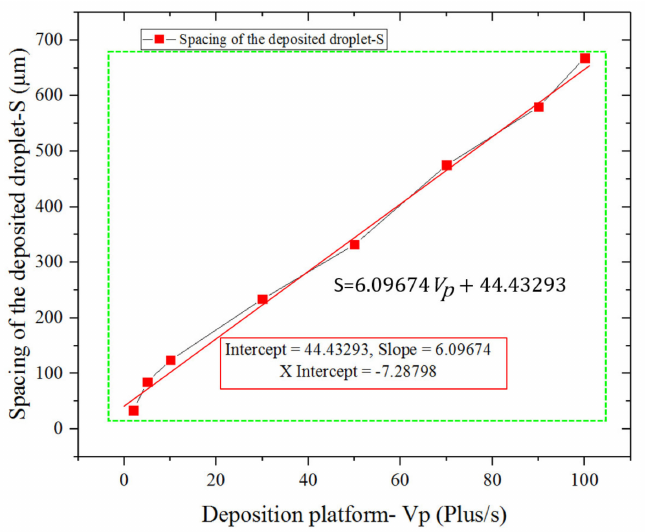
Figure 11. The approximate linear relation of droplet spacing versus speed of the deposition